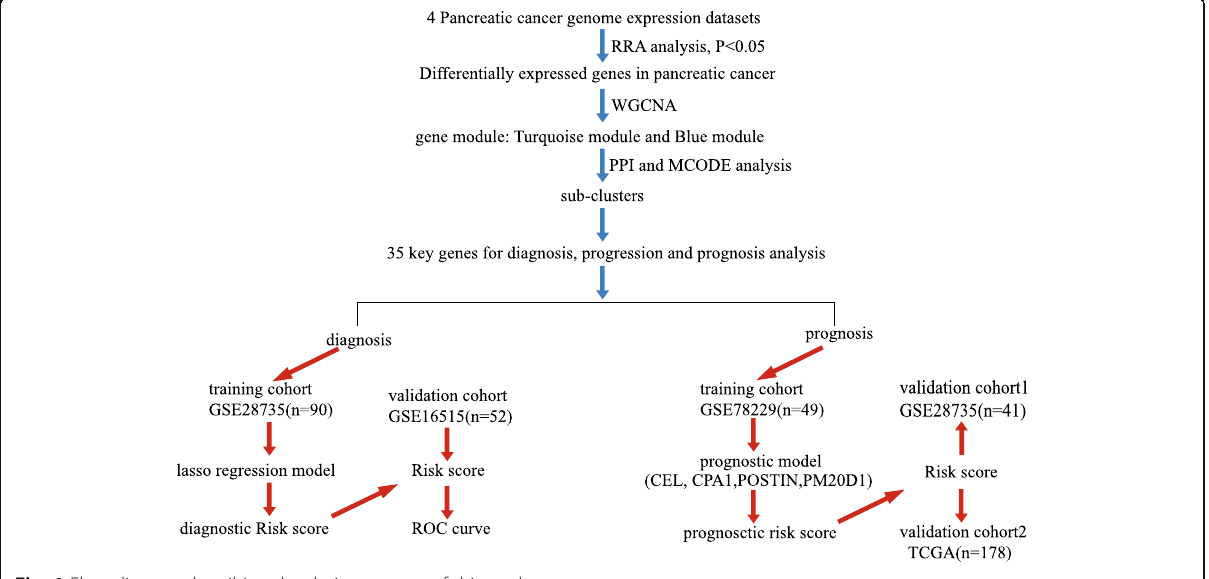
Fig. 1 Flow diagram describing the design process of this